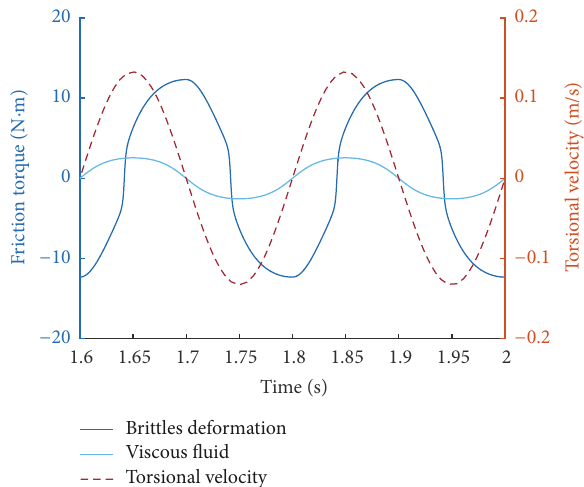
Figure 18: Trajectory of bristle projection and drilling pipe torsional oscillation in time domain.